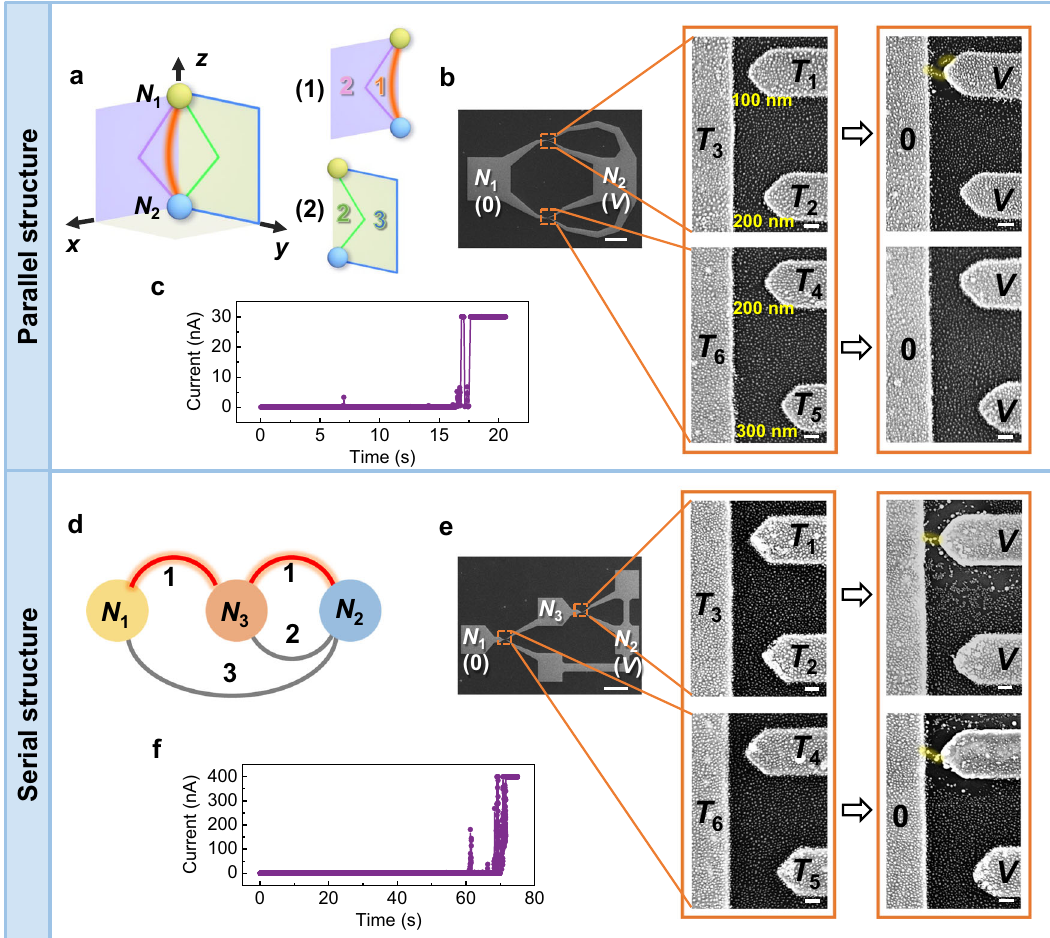
Fig.2|Integrationschemesofthemodulationunits.a Schematicillustrationofa 3Dgraphstructure.Fouredgeswithdifferentweightsbetweenthenodes N 1 and N 2 exist in the two different space dimensions represented by two mutually perpen- dicular planes (i.e., x =0, y =0), where the edge with the weight of 1 (orange color) and the edge with the weight of 2 (pink color) exist in the (1) plane y =0 while the edge with the weight of 2 (green color) and the edge with the weight of 3 (blue color)existinthe(2)plane x =0. b SEMimagesof aparallelstructurecomposedof two basic modulation units mapping with the graph structure in a : global con fi g- urationandvoltagebiasscheme(leftpanel,scalebar:50 μ m);initialmorphologyof each unit (middle panel, scale bar: 100nm); connectivity pattern of conductive fi lament after memristive switching (right panel, scale bar: 100nm). c Corresponding time-dependent current measurement from the N 2 electrode